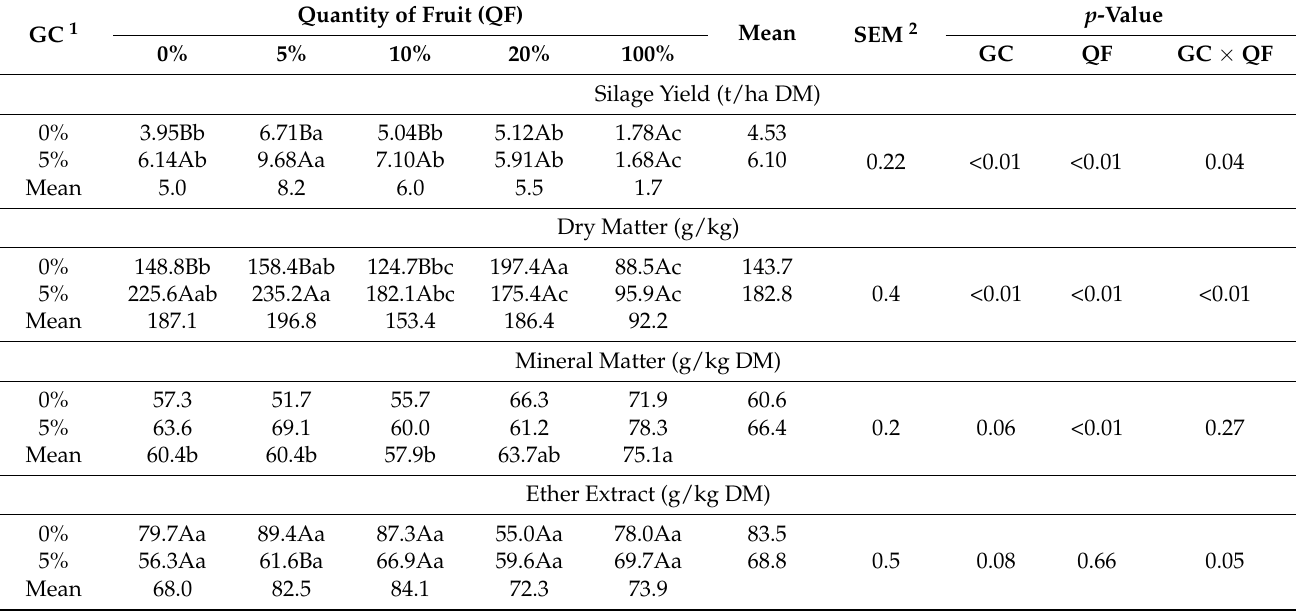
Table 1. Silage yield, chemical composition, loss quantification, DM recovery, pH, and ammonia nitrogen of silages with different mixtures of melon biomass and use of ground